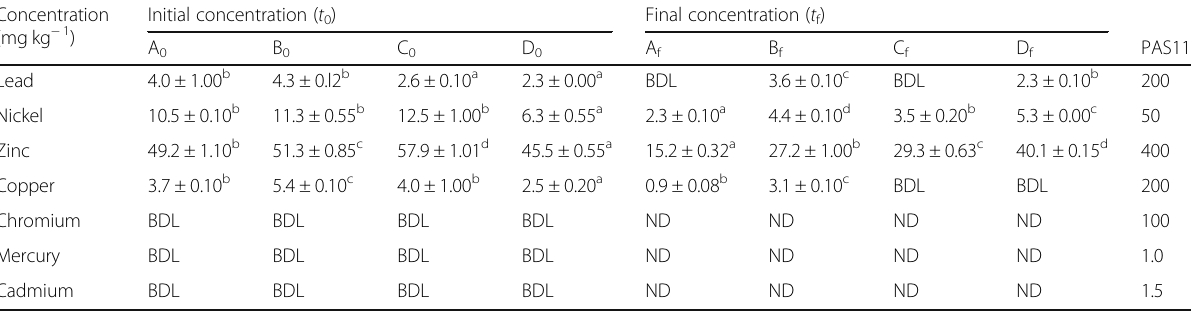
Table 5 Heavy metal concentrations in feedstock ( t 0 ) and digestate ( t f ) Concentration (mg kg − 1